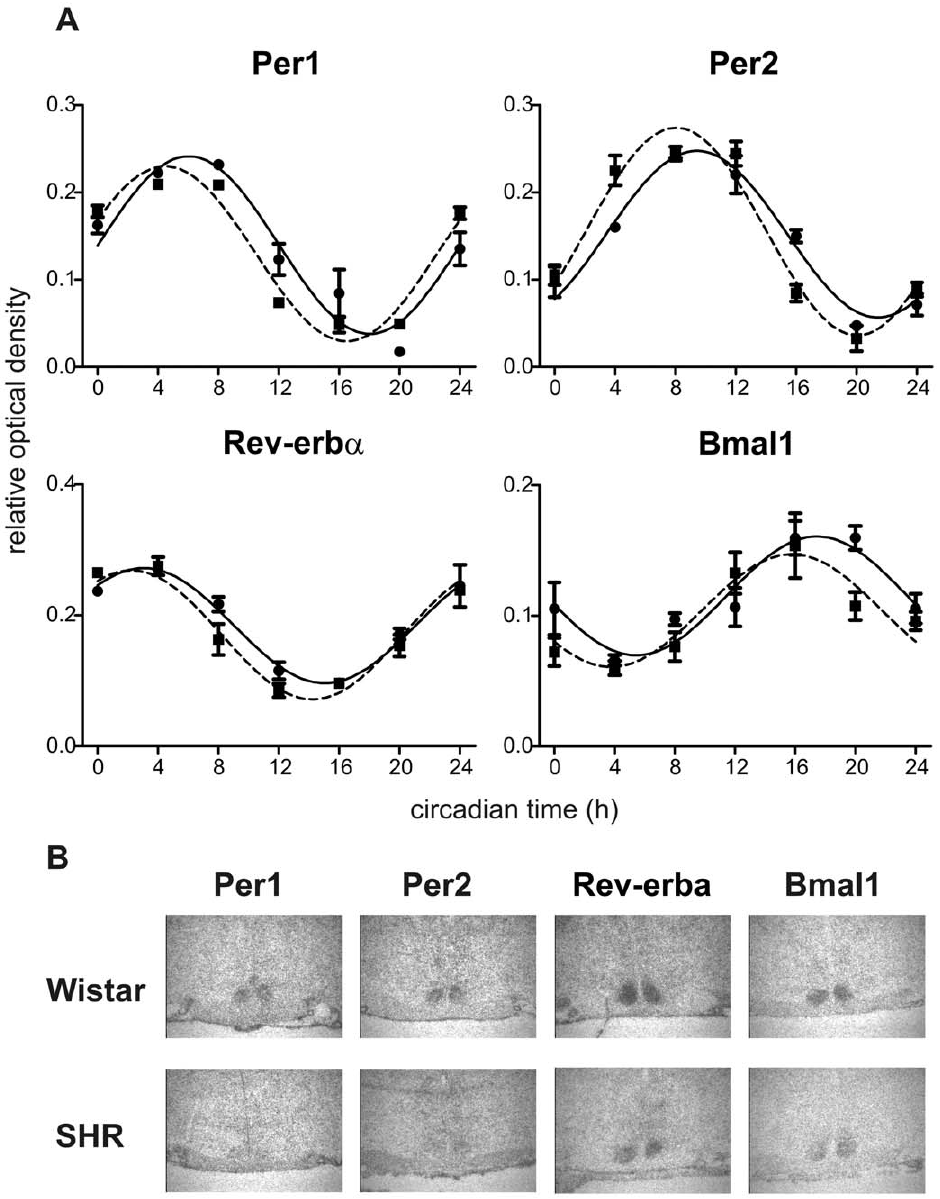
Figure 2. Clock gene expression in the suprachiasmatic nucleus of Wistar rats and SHR. A) Clock gene expression profiles in the SCN. Wistar rats (full line) and SHR (dashed line) were maintained under LD12:12, released into darkness and sampled in 4-h intervals during the 24 h. Daily profiles of Per1 , Per2 , Rev-erb a and Bmal1 mRNA levels were determined by in situ hybridization. Data are expressed as relative optical density measured in the middle section of the SCN. Time is expressed as circadian time (h) with CT0 corresponding to lights-on in the previous LD cycle (for details, see Methods). Data were fitted by cosine curves and each point represents the mean 6 S.E.M. of 3 (SHR) or 5 (Wistar rat) animals. B) Representative autoradiographs of the SCN sections in Wistar rats and SHR examined by in situ hybridization for Per1 , Per2 , Rev-erb a and Bmal1 expression at CT12, 16, 8 and 20, respectively (magnified 48 6 ).